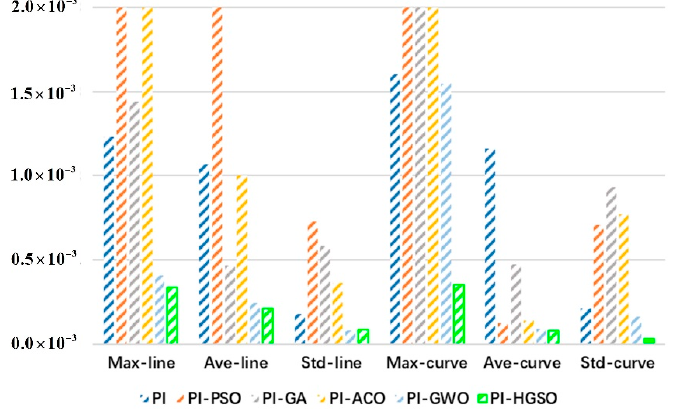
Figure 8. The comparative results of PI-HGSO and other algorithms about errors.